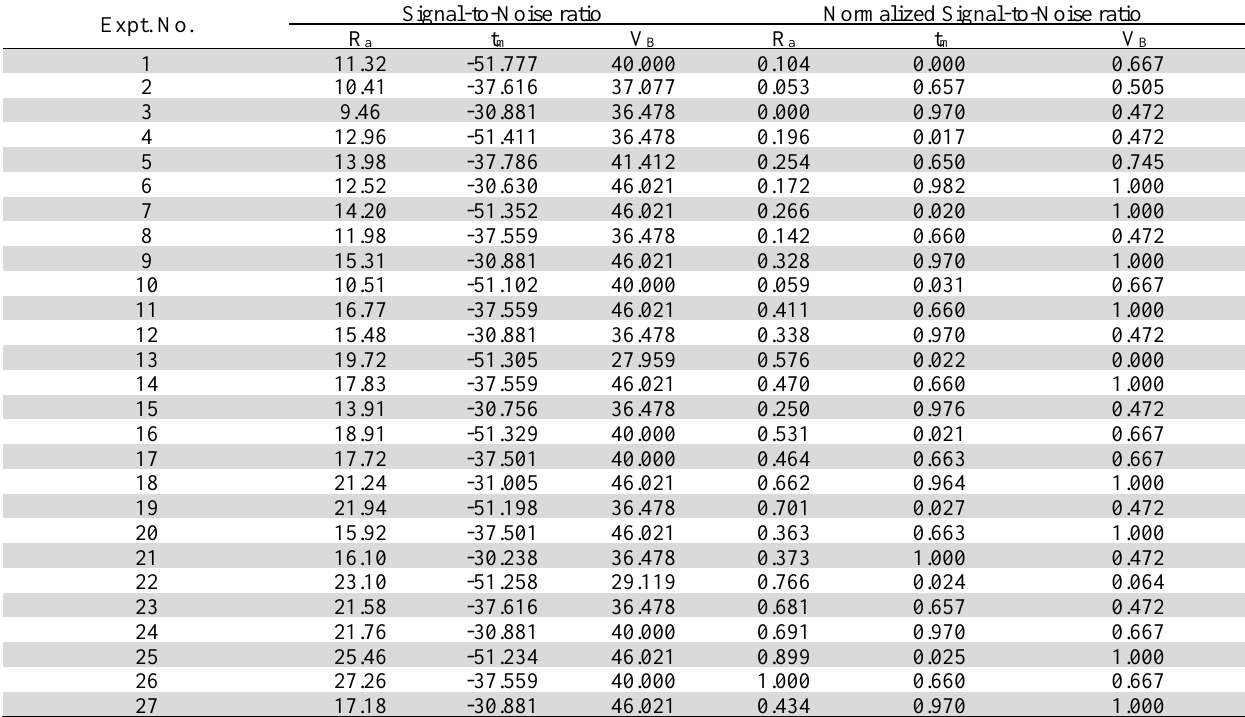
Table 3 Normalized dataset of Signal-to-Noise ratios Expt. No.